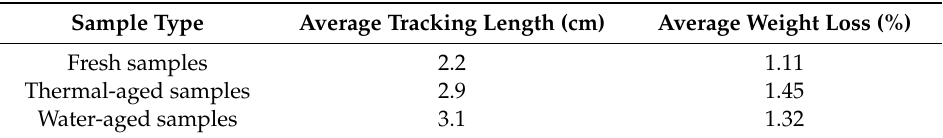
Table 2. Comparison of tracking length and weight loss.